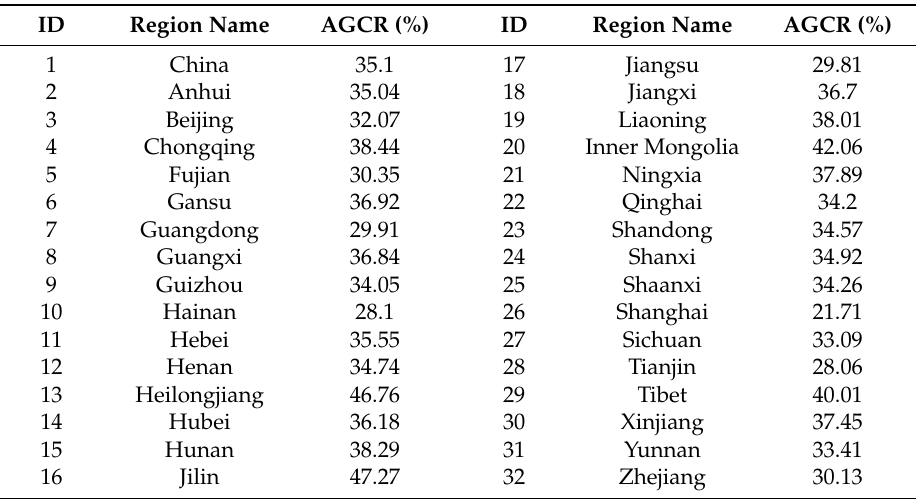
Table 2. AGCR of China and 31 provincial administrative regions.